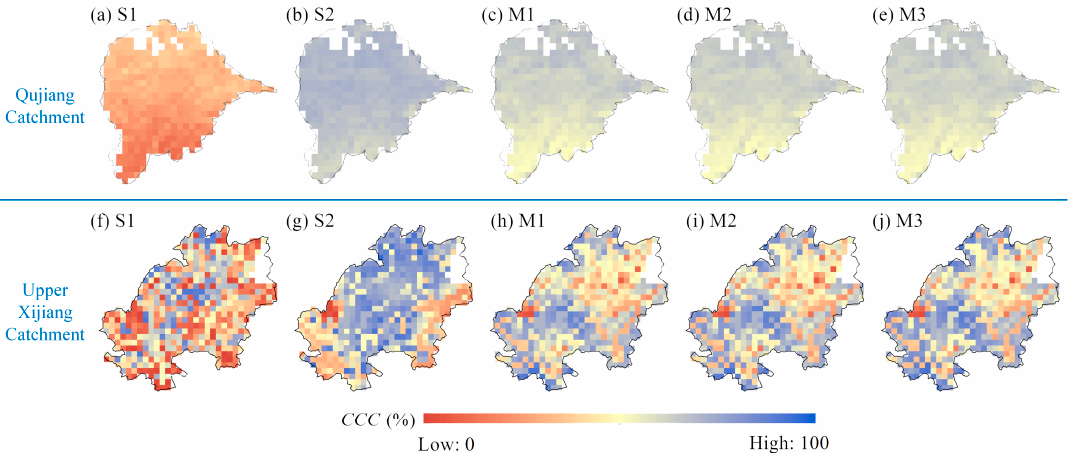
Figure 10. Gridded Lin’s Concordance Correlation Coefficient ( CCC ) for SM (%) based on the most likely parameter values in multiple scenarios (S1–S2, M1–M3) during the validation period in Qujiang catchment ( a – e ) and Upper Xijiang catchment ( f – j ).